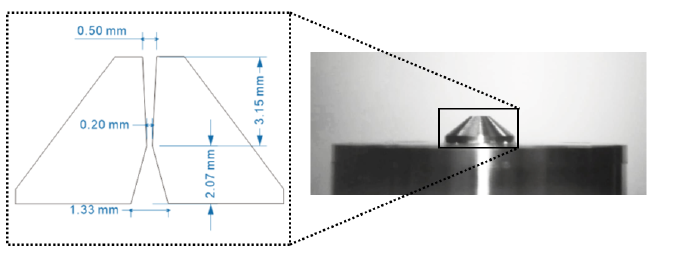
Figure 7. ( left ) Sketch of the nozzle used in our work. ( right ) The photo of our nozzle.